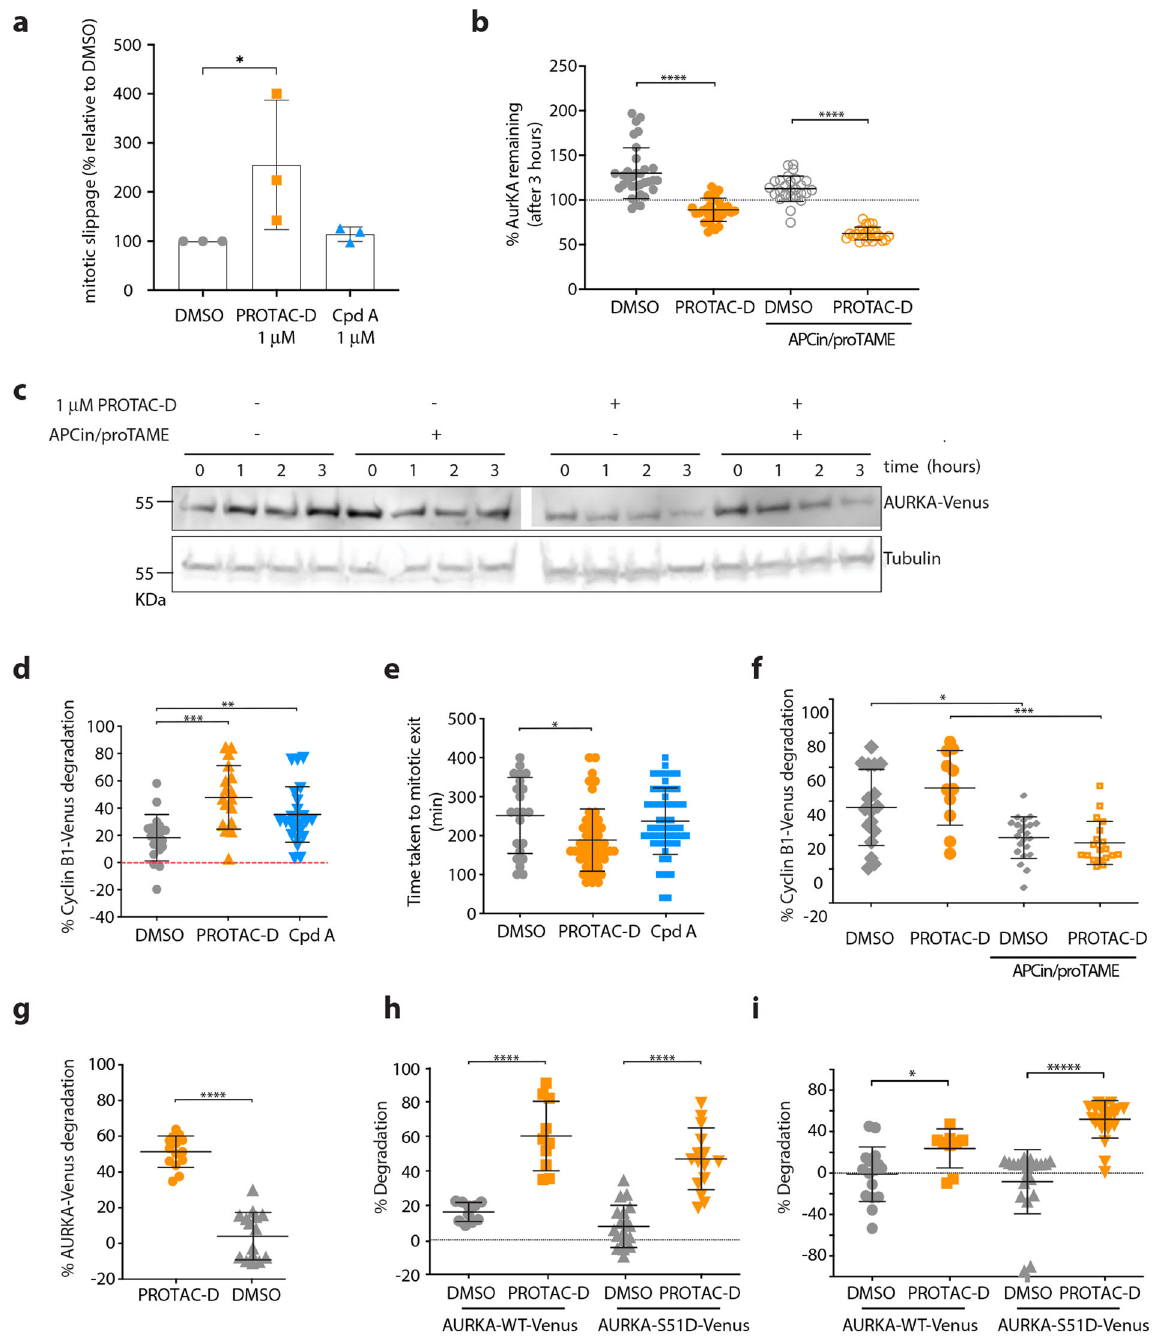
Fig. 2 CUL4-mediated AURKA destruction is independent of known pathways of AURKA degradation. a RPE1-AURKA-Venus KI cells treated as in Fig. 1d were scored for mitotic slippage (exit from mitosis in presence of STLC). Percentage of cells undergoing slippage after 3 h treatment with PROTAC-D or Cpd A is shown relative to DMSO-treated cells. Mean values were generated from three identical experiments (where n ≥ 30 cells), plotted with error bars to indicate SDs and tested by ordinary one-way ANOVA with Dunnett ’ s post-hoc test for signi fi cance. b , c Degradation of AURKA-Venus in mitotic- arrested RPE1-AURKA-Venus KI cells after treatment with PROTAC-D in the presence of APCin/proTAME. Degradation was measured in single cell assays, with data shown as scatter plots (bars to indicate means ± SDs) tested with unpaired t -Test or Mann – Whitney U -test for signi fi cance ( b ) or visualized as a time-course of drug treatment by immunoblot ( c ). d – f RPE1-Cyclin B1-Venus KI cells treated with PROTACs to investigate mitotic slippage. Increased degradation of Cyclin B1 – Venus following PROTAC-D treatment ( d ), correlates with increased rate of mitotic exit ( e ) (both results statistically tested by ordinary one-way ANOVA with Dunnett ’ s post-hoc test for signi fi cance) and is blocked by co-treatment with APC/C inhibitors APCin (40 µ M) and proTAME (20 µ M) (unpaired t -Test or Mann Whitney U -test for signi fi cance) ( f ). g – i “ Non-degradable ” AURKA-Venus is degraded ef fi ciently in response to PROTAC-D: AURKA-Venus- Δ 32-66 ( Δ A-box) expressed in RPE1 cells (tet-inducible RPE1-FRT/TO pool) is sensitive to PROTAC-D (unpaired t -test for signi fi cance) ( g ). WT or Ser51D versions of AURKA-Venus transiently electroporated into U2OS cells are equally sensitive to PROTAC-D treatment in either mitotic cells arrested by STLC ( h ) or interphase cells ( i ) (unpaired t -test or Mann – Whitney U -test for signi fi cance). Ongoing protein synthesis is likely to mask the degradation rate of Venus-tagged protein in interphase cells. COMMUNICATIONS BIOLOGY| (2021) 4:640 |https://doi.org/10.1038/s42003-021-02158-2|www.nature.com/commsbio